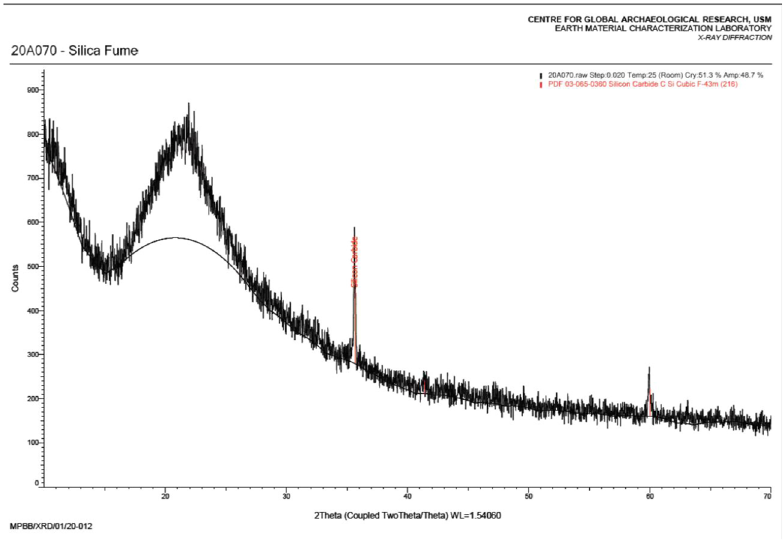
Figure 2: Mineralogy of NSS, adapted from ref. [ 13 ]